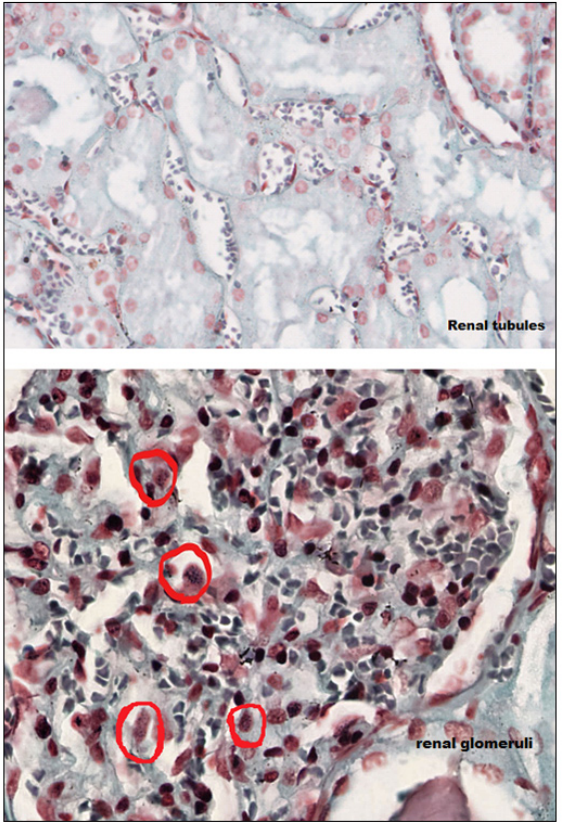
Figure 3. Human kidney histochemistry. Human kidney Gram stain. Absence of Gram positive granules in the renal tubules (magnification, ×43.3). Gram positive granules were only present on the glomeruli, red circles